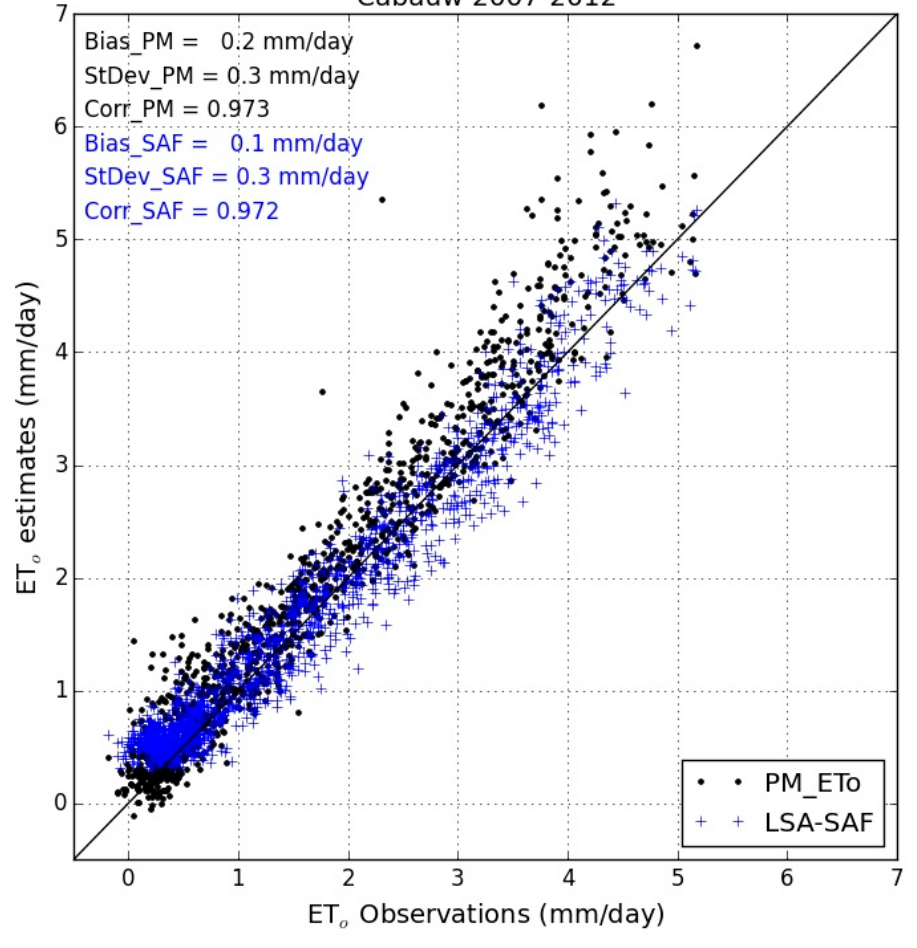
Figure 1. Daily estimates of reference evapotranspiration as obtained by the LSA-SAF (blue crosses) versus daily in situ observations obtained for Cabauw (from eddy-covariance flux measurements) for the 2007–2012 period. For reference, Penman-Monteith (PM_ETo) estimates obtained using in situ observations are also plotted (black dots). The mean difference (bias), standard deviation of differences and correlation between estimations and observed time-series are also shown.